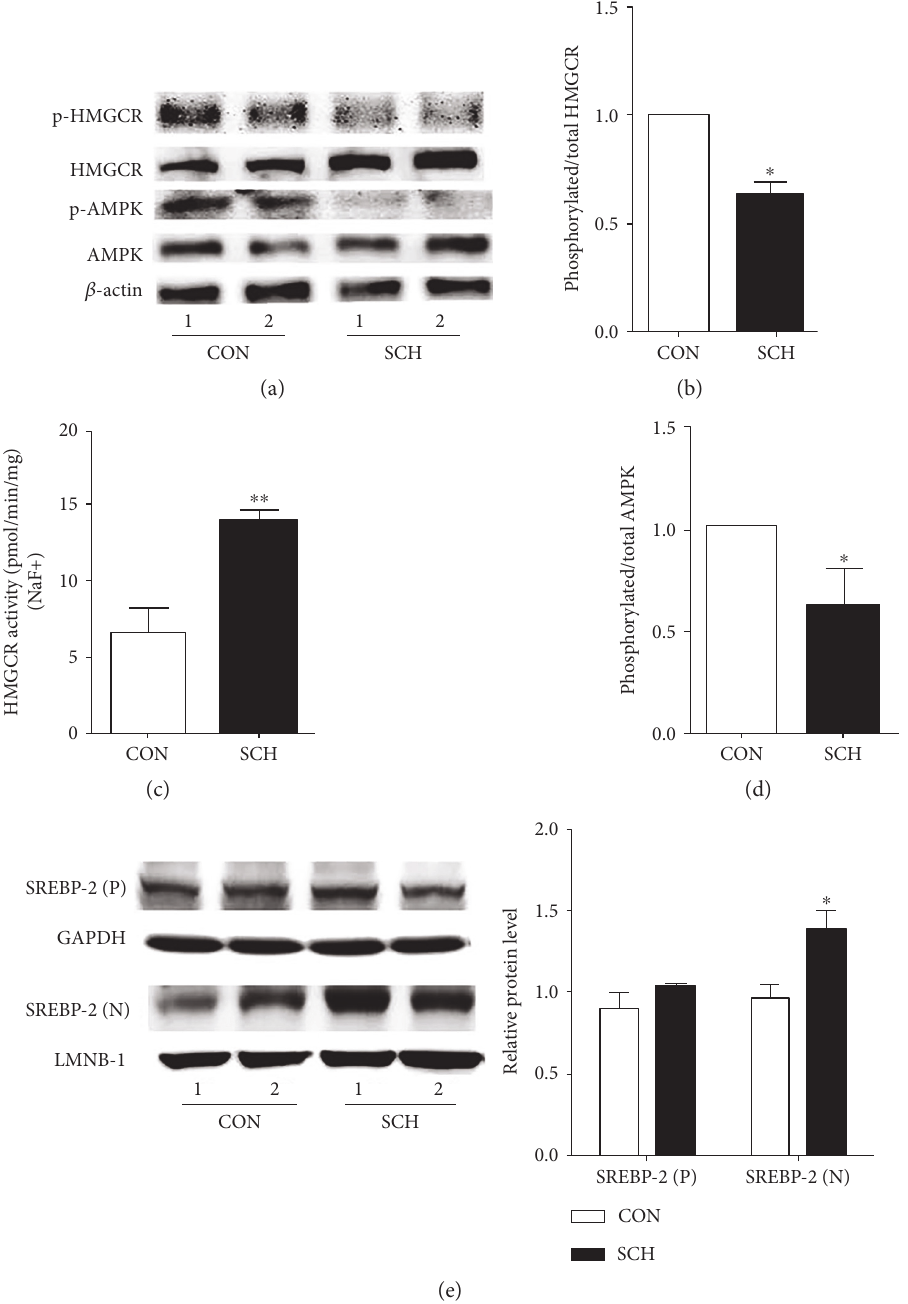
Figure 3: The phosphorylation of HMGCR and AMPK decreased in SCH mice. (a) The expression levels of p-HMGCR, t-HMGCR, p-AMPK, and t-AMPK in SCH and control mice were analyzed using western immunoblotting analysis. The same membranes were reprobed with anti- β -actin antibody to con fi rm equal loading of proteins for each sample. Representative results from three independent experiments are shown. (b) The ratios of p-HMGCR/HMGCR in the livers of control mice and SCH mice were assessed by semiquantitative analysis. (c) Hepatic HMGCR activity was measured in the presence of NaF. (d) The ratios of p-AMPK/AMPK in the livers of control mice and SCH mice. (e) The expression of precursor and mature SREBP-2 in SCH and control mice. Data are representative of three independent experiments. ∗ p < 0 05 and ∗∗ p < 0 01 versus control